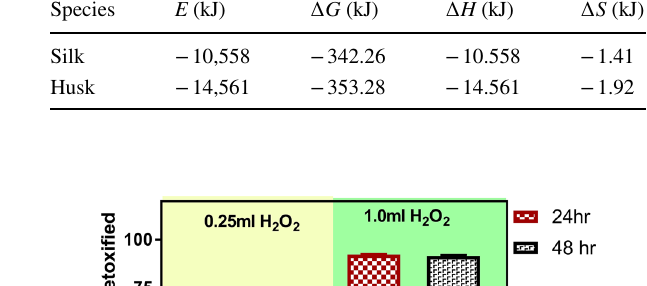
Fig. 10 Electrophoretic pattern of crude and peroxidase enzyme obtained from Zea mays L waste